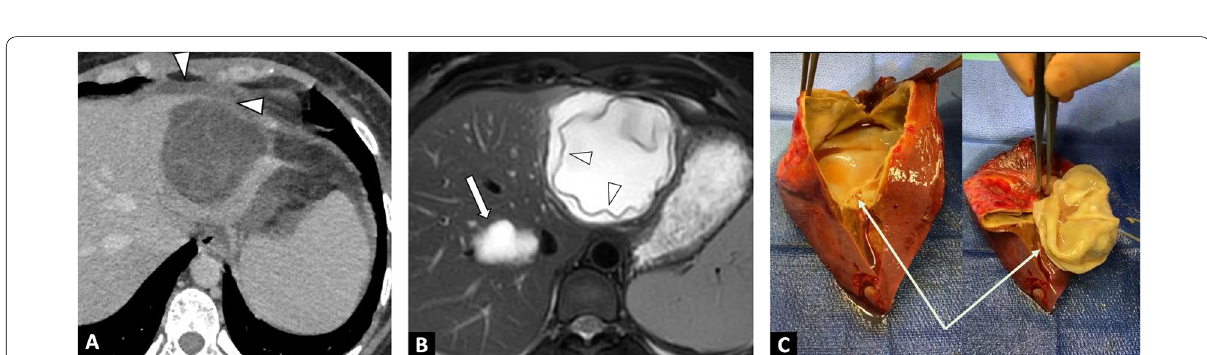
Fig. 12 Left lobe cystic echinococcosis lesion in a 43‑year‑old woman revealed by abdominal pain associated with fever. A CT image in the axial plane obtained during the portal phase of enhancement showing peritoneal rupture of left lobe CE lesion (arrowheads). Peritoneal effusion contiguous to the anterior surface of the left lobe CE lesion. B T2‑weighted fat‑suppressed MR image in the axial plane showed internal detached membrane (water lily sign, arrowheads) of the left lobe lesion, diagnosing a transitional stage of CE (CE3a). Second CE lesion CE1 (arrow). C Correlation with macroscopic findings. Internal membrane of the CE3a cyst (arrows)